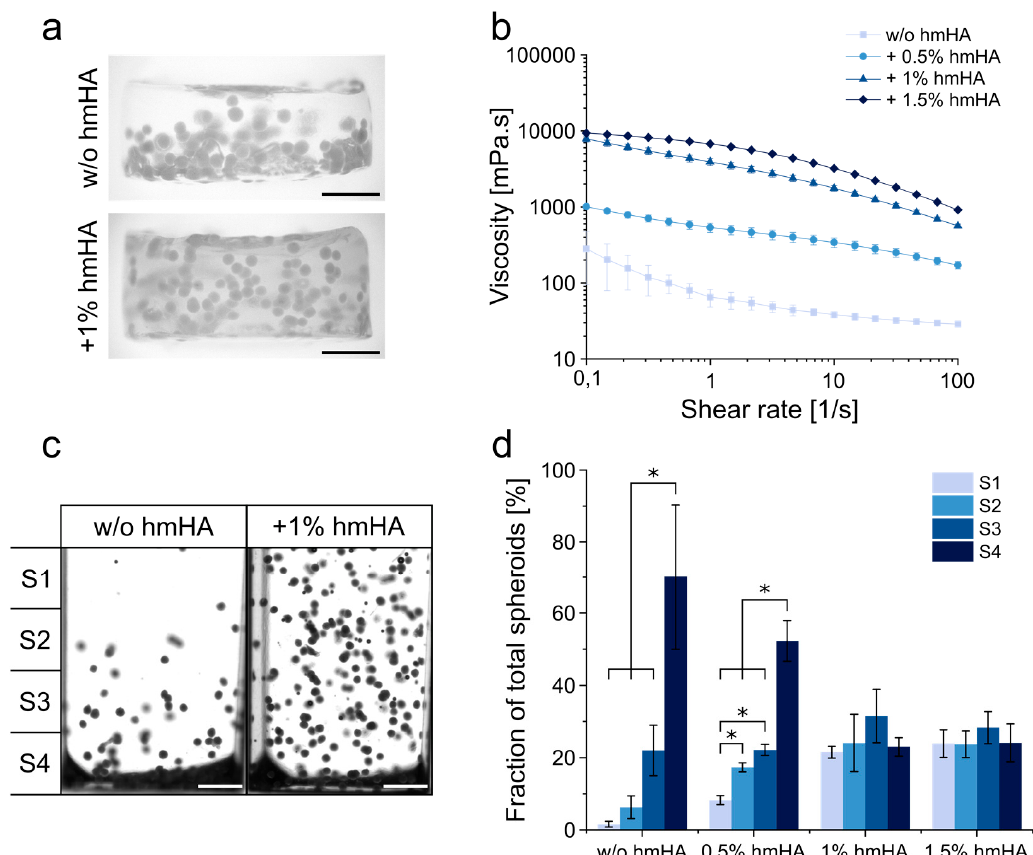
Figure 2. Modification of hyaluronic acid (HA) hydrogel formulation to ensure homogeneous spheroid distribution. ( a ) Representative images of printed gels without and with the addition of 1 wt% high molecular hyaluronic acid (hmHA). Scale bars represent 1000 µm. ( b ) Shear viscosity of the different hydrogel formulations without and with the addition of hmHA. Data are presented as mean ± standard deviation ( n = 4). ( c ) Analysis of sedimentation behavior of human adipose-derived stromal cell (ASC) spheroids in non-crosslinked HA–SH hydrogel formulations without and with 1 wt% unmodified hmHA after 30 min. Images were divided into 4 sectors for further analysis (S1–S4). Scale bars represent 1000 µm. ( d ) Fraction of spheroids in sectors S1–S4 after 30 min in different gel formulations (without and with 0.5, 1 and 1.5 wt% hmHA). Data are presented as mean ± standard deviation ( n = 3). Statistically significant differences are indicated by * ( p < 0.05).